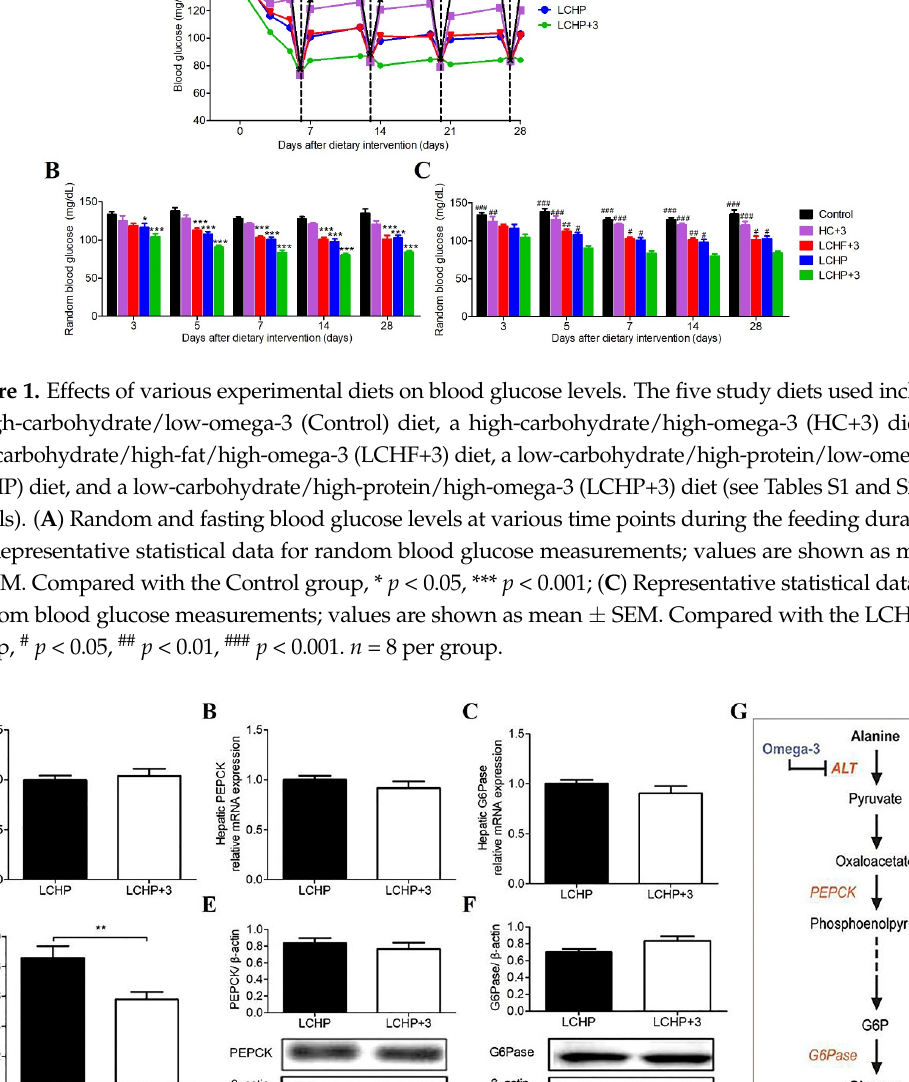
Figure 2. Effects of the LCHP+3 diet on the key enzymes involved in amino acid gluconeogenesis. ( A ) mRNA expression of hepatic ALT; ( B ), mRNA expression of hepatic PEPCK; ( C ) mRNA expression of hepatic G6Pase; ( D ) Hepatic ALT activity; ( E ) Protein expression of hepatic PEPCK; ( F ) Protein expression of hepatic G6Pase; ( G ) Potential target of omega-3 in the amino acid gluconeogenesis pathway. Solid and dashed lines represent one-step and multiple-step reaction, respectively. ALT, alanine aminotransferase; PEPCK, phosphoenolpyruvate carboxy kinase; G6Pase, glucose 6- phosphatase; LCHP, low-carbohydrate/high-protein/low-omega-3; LCHP+3, low-carbohydrate/high- protein/high-omega-3. Values are shown as mean ± SEM; ** p < 0.01. n = 8 per group.